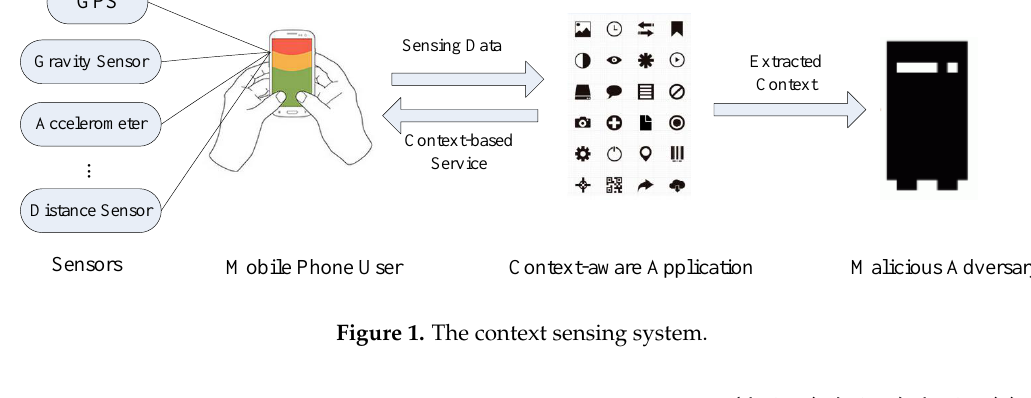
Figure 1. The context sensing system.